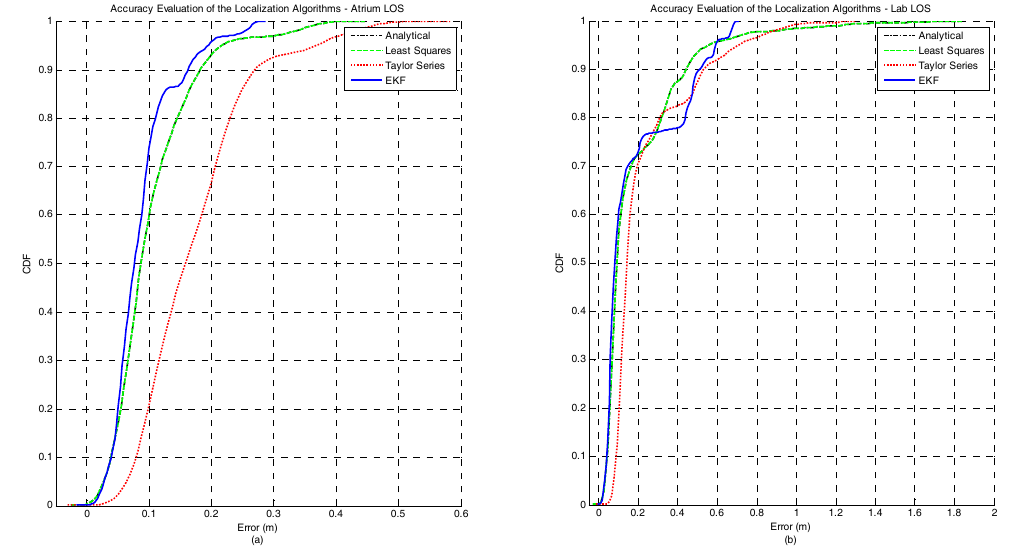
Figure 2. Comparison of the accuracy achieved by each algorithm for static nodes without human body interference. The localization algorithms were run in two different scenarios: ( a ) atrium and ( b ) lab. Table 3. Performance comparison of the localization algorithms for the metrics accuracy, precision, and RMSE. All localization algorithms are compared for both atrium and lab scenarios and without human body interference.